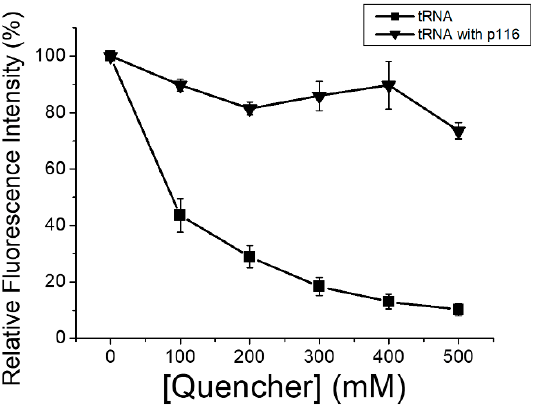
Figure 7. tRNA fluorescence quenched by the quencher iodide. In the graphs, (— ■ —) indicates the relative fluorescence intensity of free-form fluorescent-labeled tRNA in the presence of different quencher concentrations; (— ▼ —) indicates the relative fluorescence intensity of labeled tRNA associated with p116-assembled particles in the presence of different quencher concentrations. Each point is an average of three repeats; errors are standard deviations.